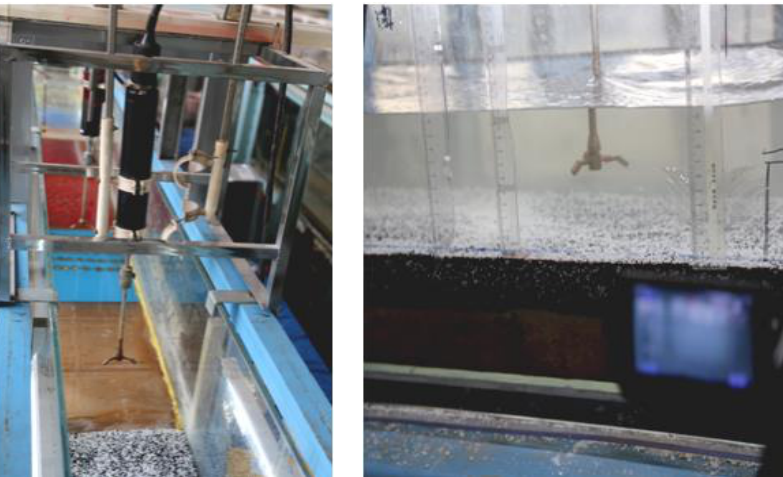
Figure 9. The layout of the 3D Doppler velocimeter (ADV) used for measuring the near-wall velocity. The left figure shows the lengthwise location of the two sets of ADV. They were arranged above the erodible bed and the observation section and used to collect the flow-velocity data. The right figure shows the vertical height of ADV above the bed, where the measuring point of the probe was about 3~5 D away from the bed, which is exactly the moving activity range of the bed load particles. D is the diameter of the bed sands. The arrangement of the ADV helps to guarantee the reliability of the data.